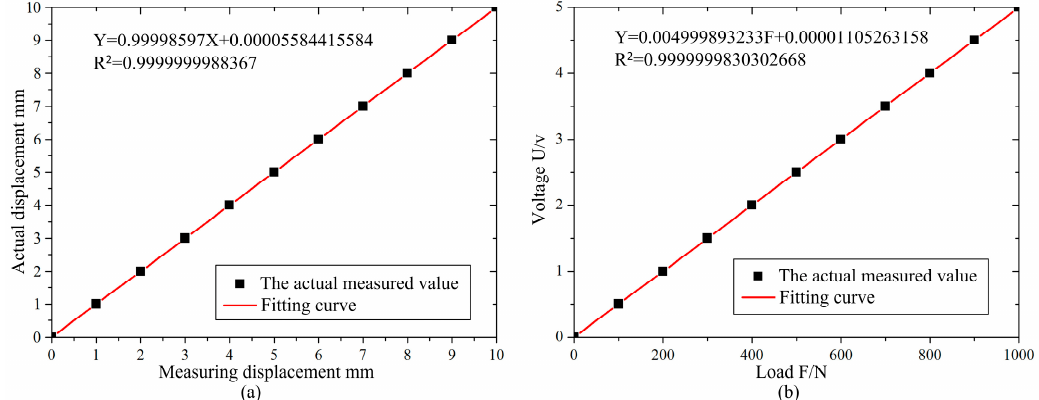
Figure 4. Sensor calibration curve diagram. ( a ) Displacement sensor calibration; ( b ) Force sensor calibration.